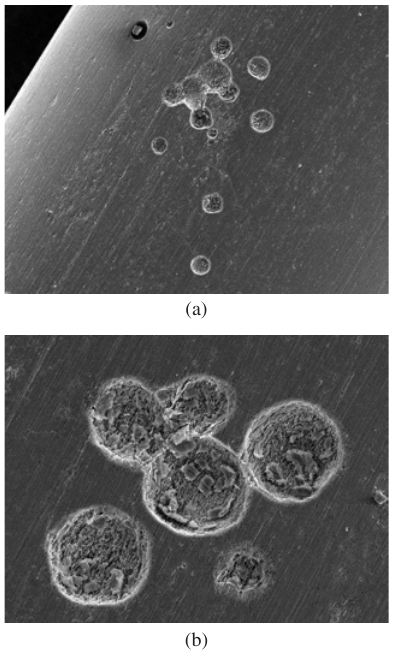
Figure 4. Micrographs of Ti6Al4V rod obtained in bromide-containing citric acid after polarization from - 1.0 to 4.0 V.